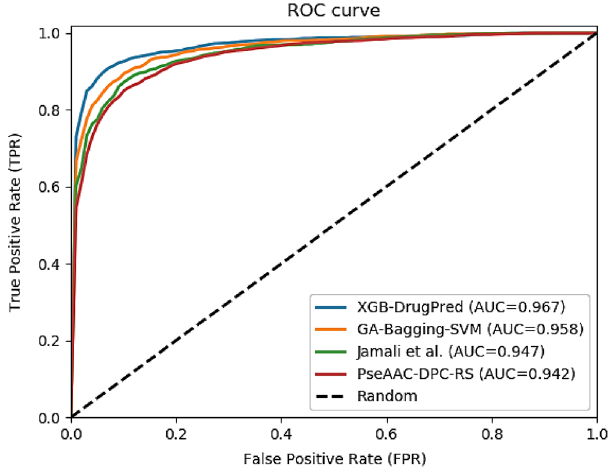
Figure 3. ROC curves of the proposed and existing